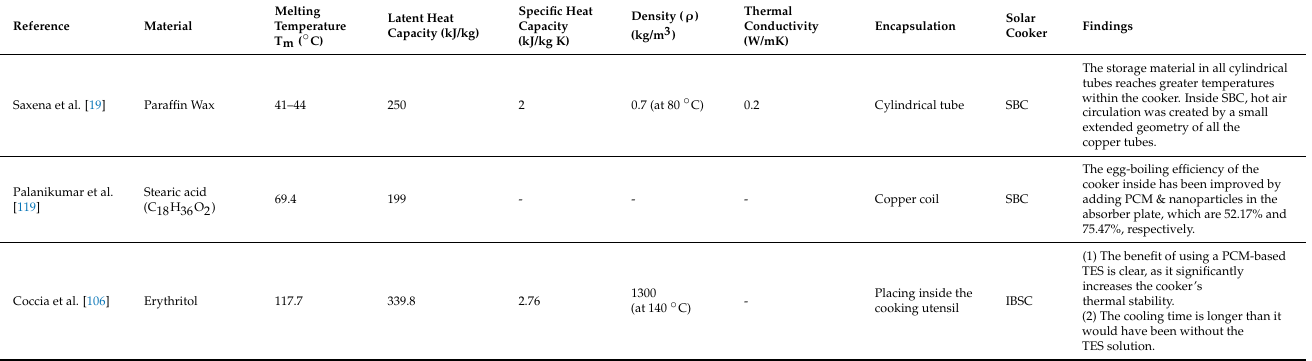
Table 3. Phase change materials used in a different configuration of the solar